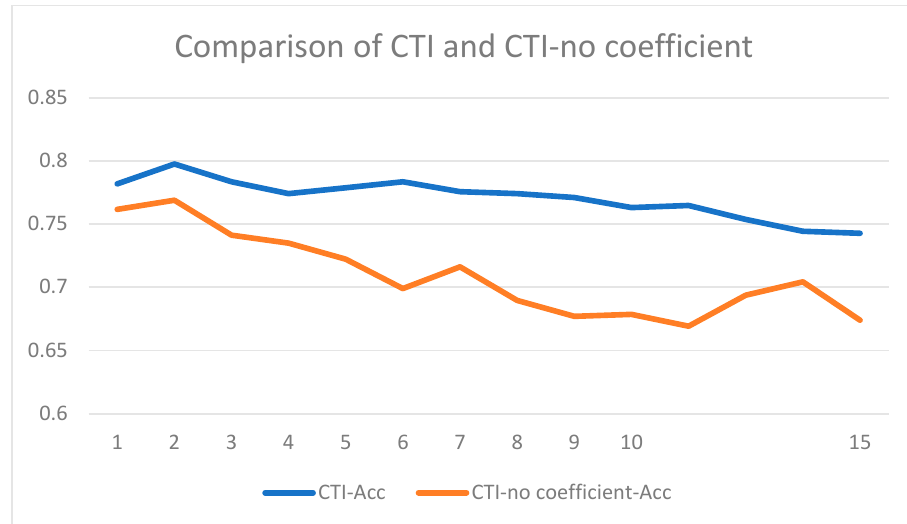
Figure 5. Comparison of CTI-Acc and CTI-no coefficient-Acc. Appl. Sci. 2020 , 10 , x FOR PEER REVIEW